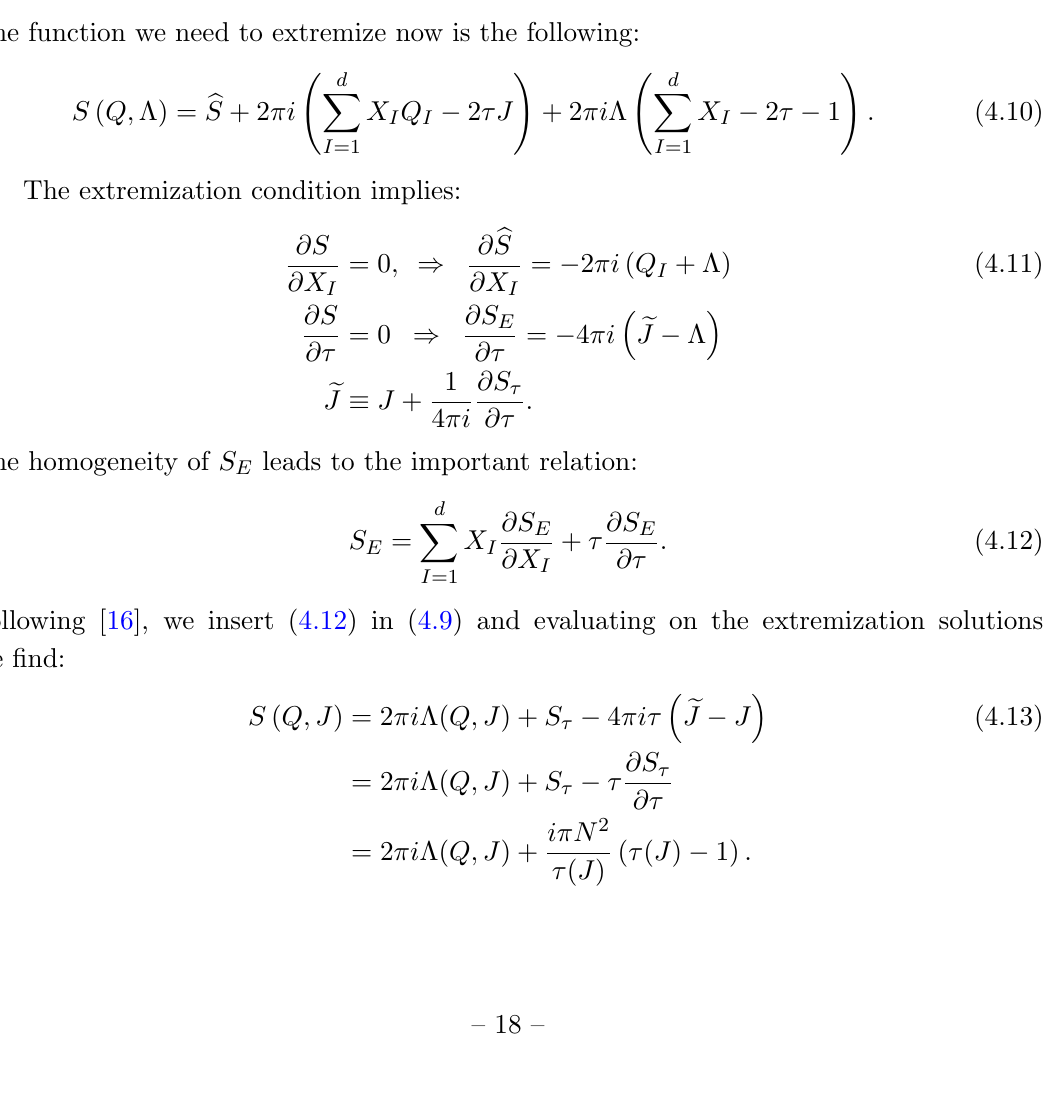
(cid:0) (cid:1) [(cid:1) I ] + 1 () X I is (cid:28) 2